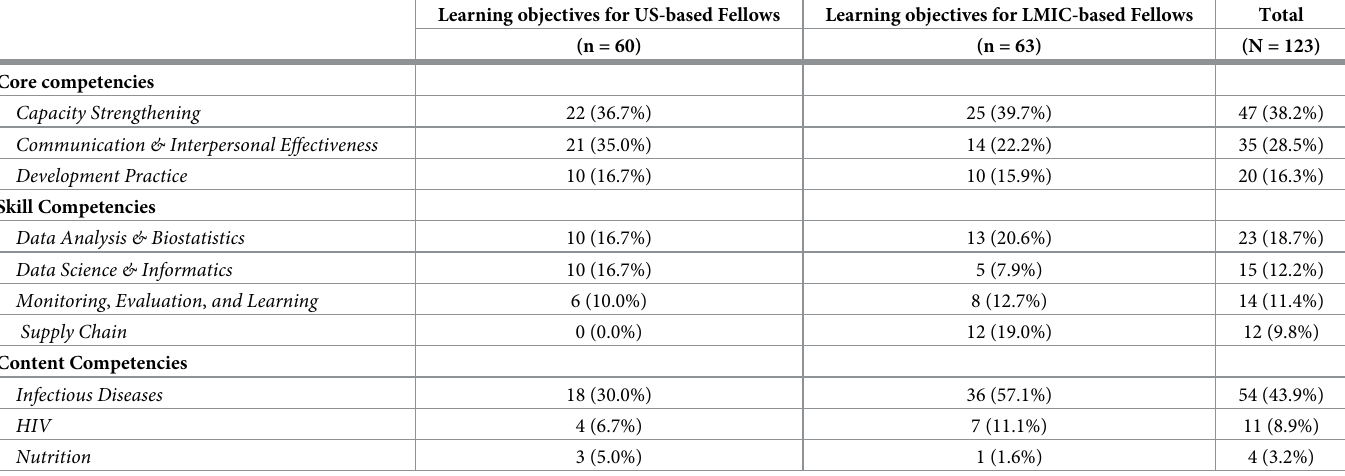
Table 2. Top 3 competencies selected in learning objectives for US-based versus LMIC-based